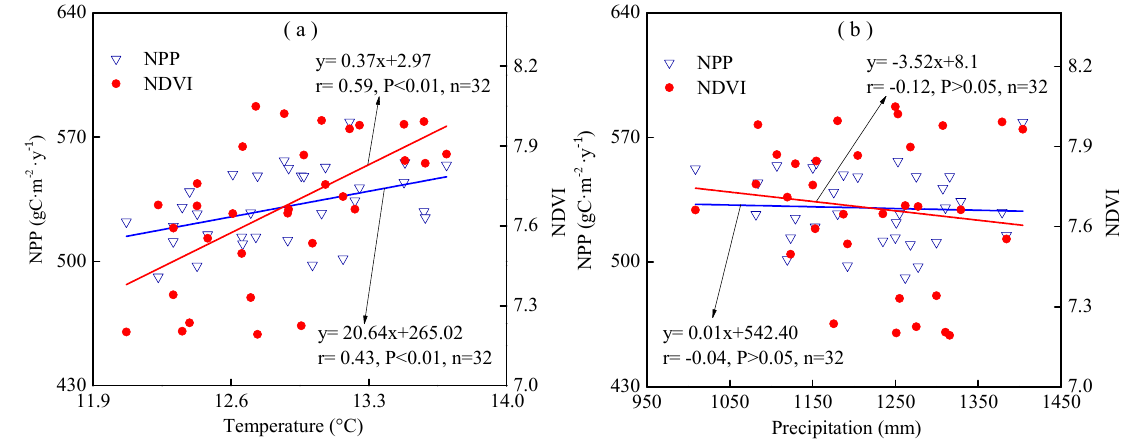
Figure 6. Correlation among the annual mean forest NPP and NDVI with temperature ( a ) and precipitation ( b ) in the Yangtze River basin during the period 1982–2013.